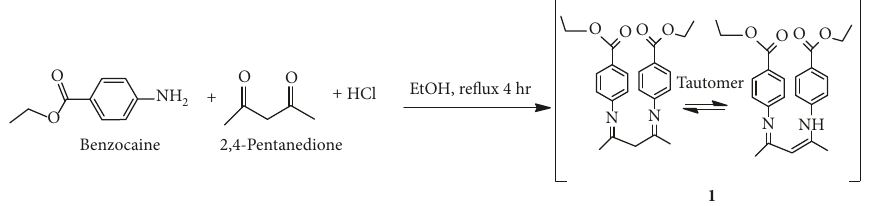
Scheme 2: Preparation of 3-diketimine and its